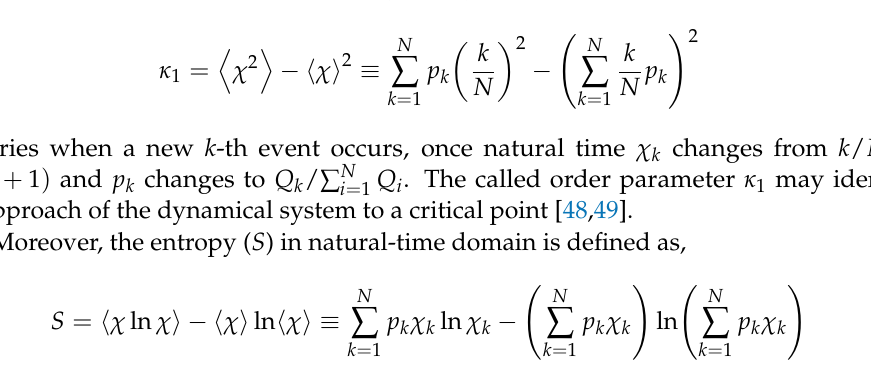
Figure 4. Natural time in the context of acoustic emission time series (adapted from ref. [48]). The natural time χ k ’s variance κ 1 is given